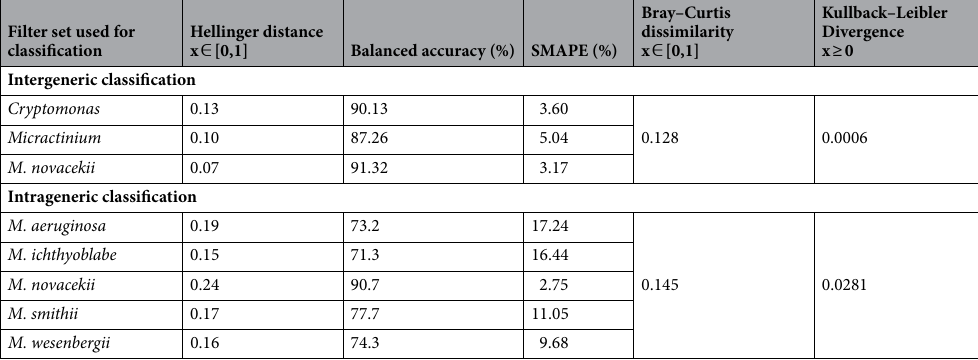
Filter set used for